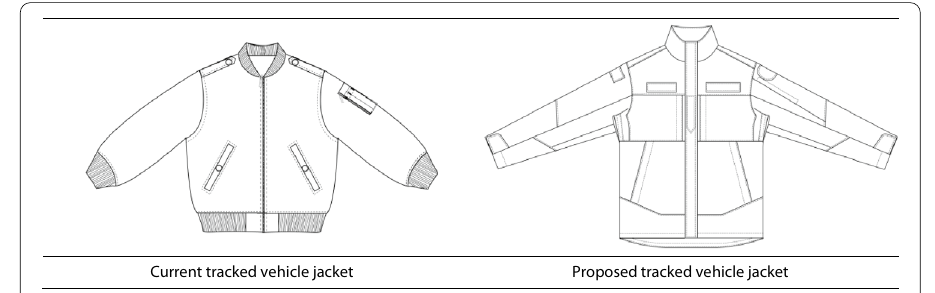
Fig. 4 Jackets for tracked vehicle